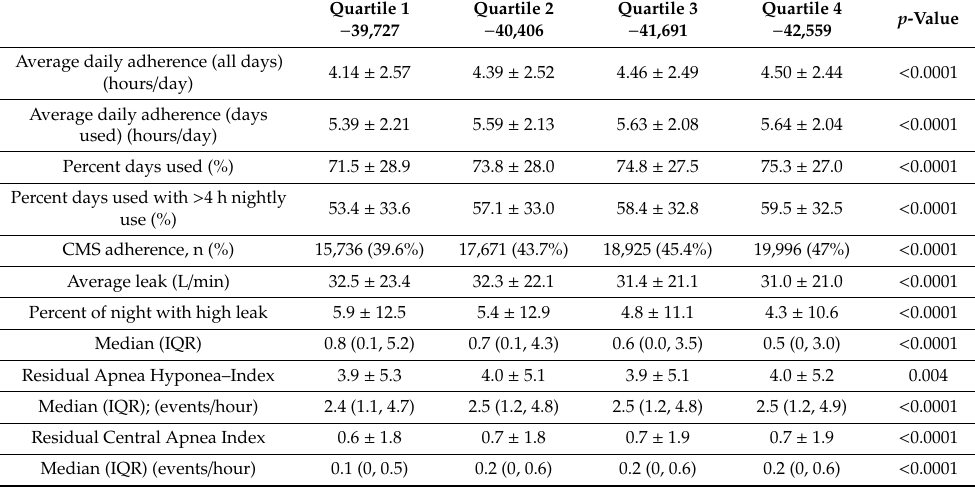
Table 2. Device adherence